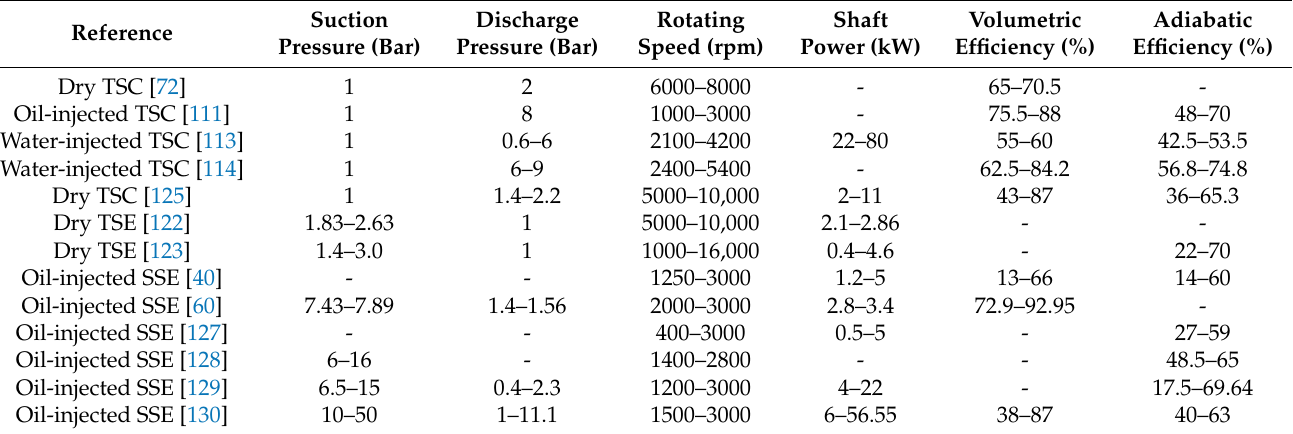
Table 2. Reported performance of screw machines for air compression and expansion